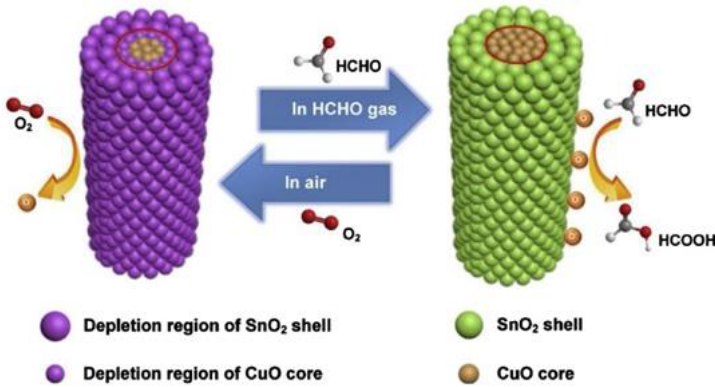
Figure 11. Three-dimensional sensing mechanism diagrams of the carrier distribution in the p-CuO/n-SnO 2 core-shell NWs when exposed in air and in HCHO gas [73]. Table 2. Formaldehyde sensing properties of functional modification of oxide semiconductor gas sensor.